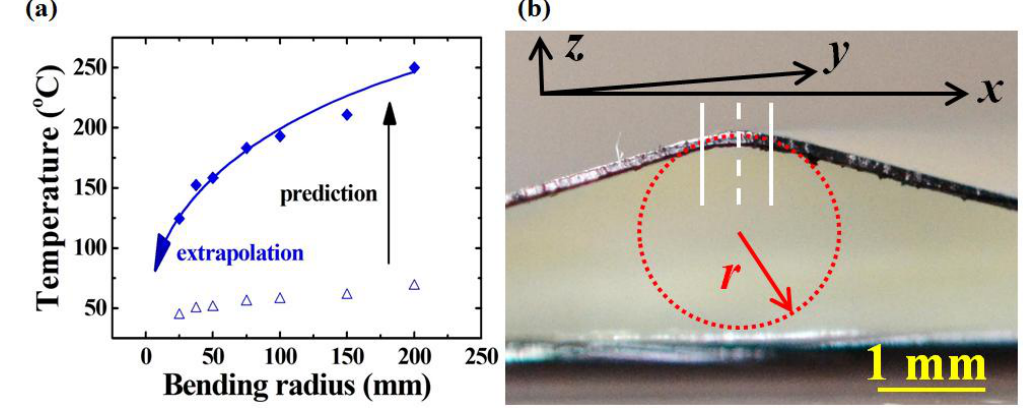
Figure 8. ( a ) The temperature prediction (solid diamond) at 12 V for the resistance in the trapezoid area in Figure 7b based on the experimental results in Figure 6a (hollow triangle). ( b ) The real bending curvature is in good agreement with the extrapolation prediction for the folding mark, where the PEN substrate is 125 μm thick, and the 10-nm-thick Au was unobservable, and therefore, neglected for the bending radius calculation. The dotted line, dashed line, and the solid line in ( b ) respectively represents for the imaginary circle with bending radius r , the cross-sectional location of the bending axis in Figure 7b and the cross-sectional location of the outer boundaries of the trapezoid in Figure